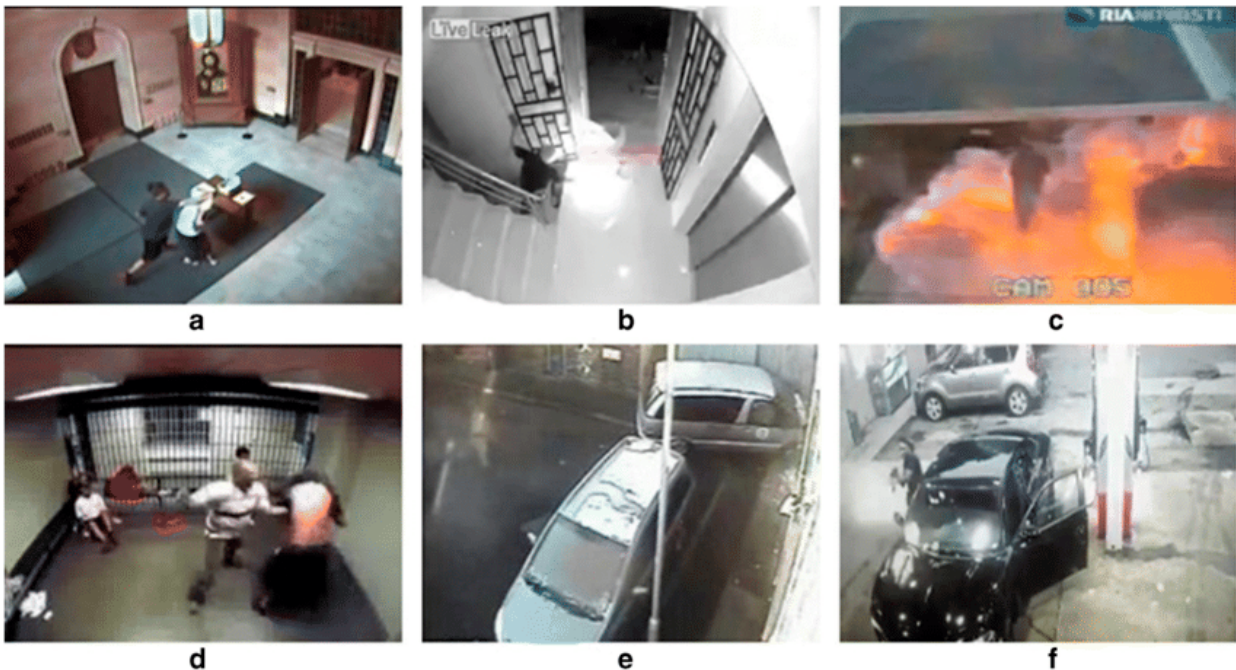
Figure 6 . Examples of different anomalies in UCF-crime dataset ( a ) Abuse ( b ) Arson ( c ) Explosion ( d ) Fight ( e ) Road Accident ( f ) Shooting .